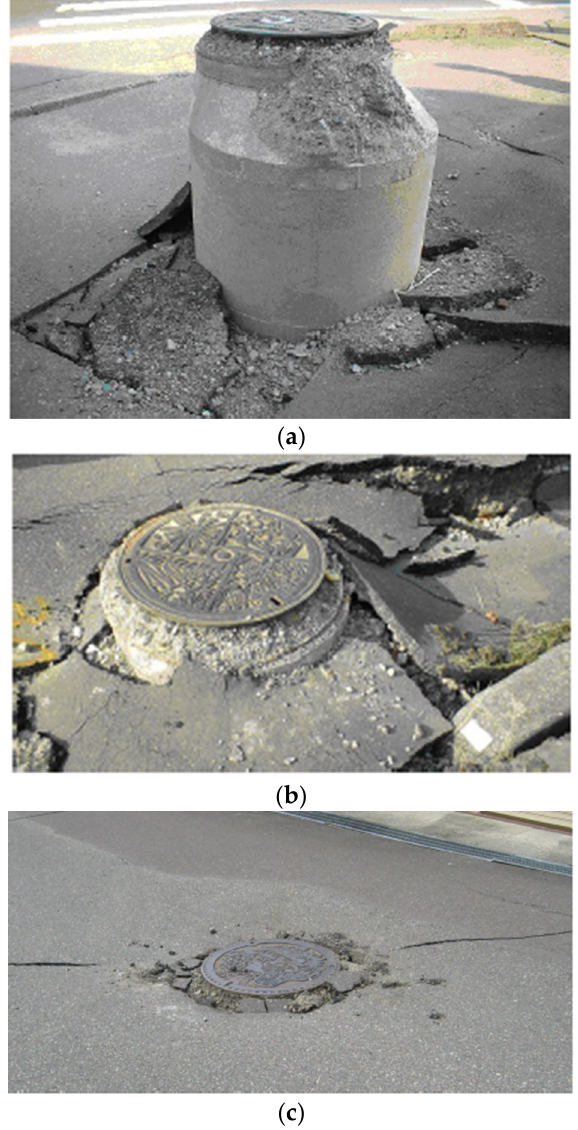
Figure 1. Examples of manhole damage caused by earthquake. (a) Case of manhole uplifted due to earthquake (b) Case of ground subsidence around manhole (c) Case where ground and manhole move separately